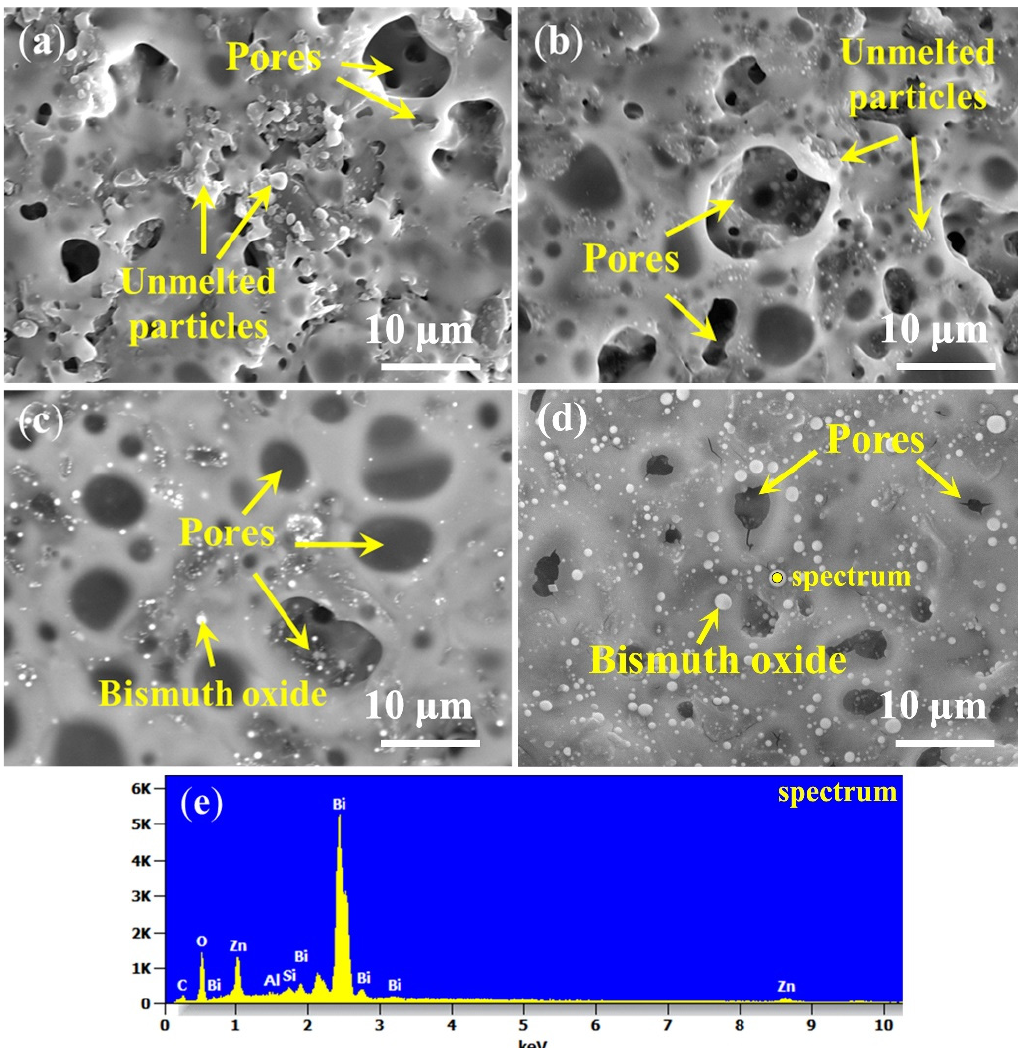
Figure 7. Surface images of the PSN/bismuth–borosilicate glass–B 4 C coatings with different bismuth glass content after oxidation at 500 °C for 2 h in air: ( a ) Bi10; ( b ) Bi20; ( c ) Bi30; ( d ) Bi40; and ( e ) EDS result of point labeled in ( d ).